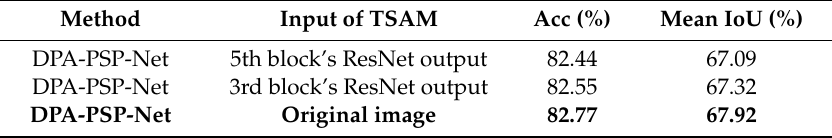
Table 2. Performance comparison for the total spatial attention module (TSAM) at di ff erent